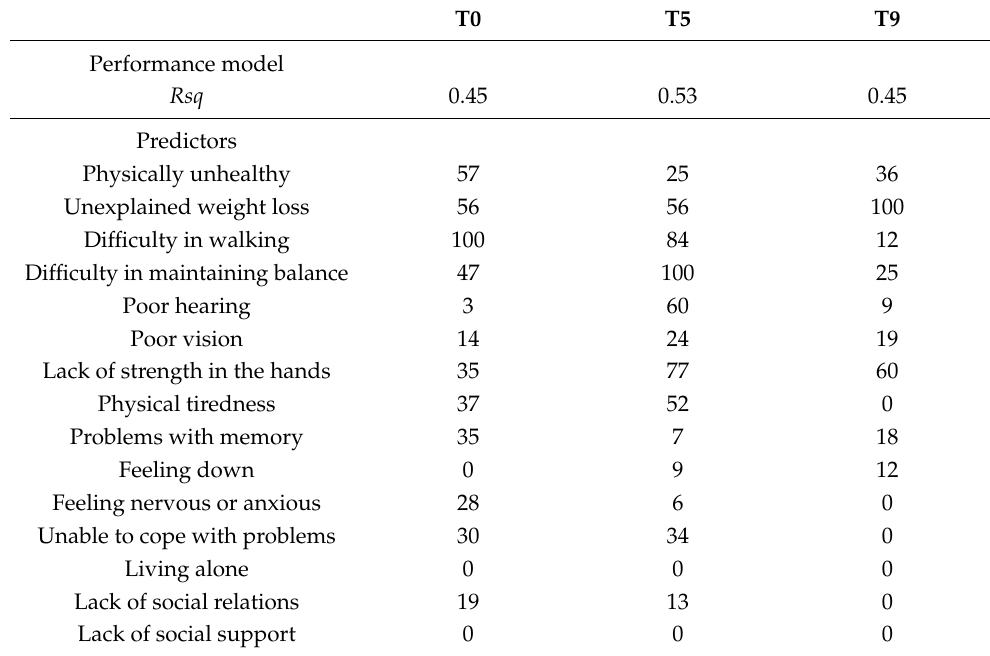
Table 4. Rsq -values and relative importance TFI items for the total disability